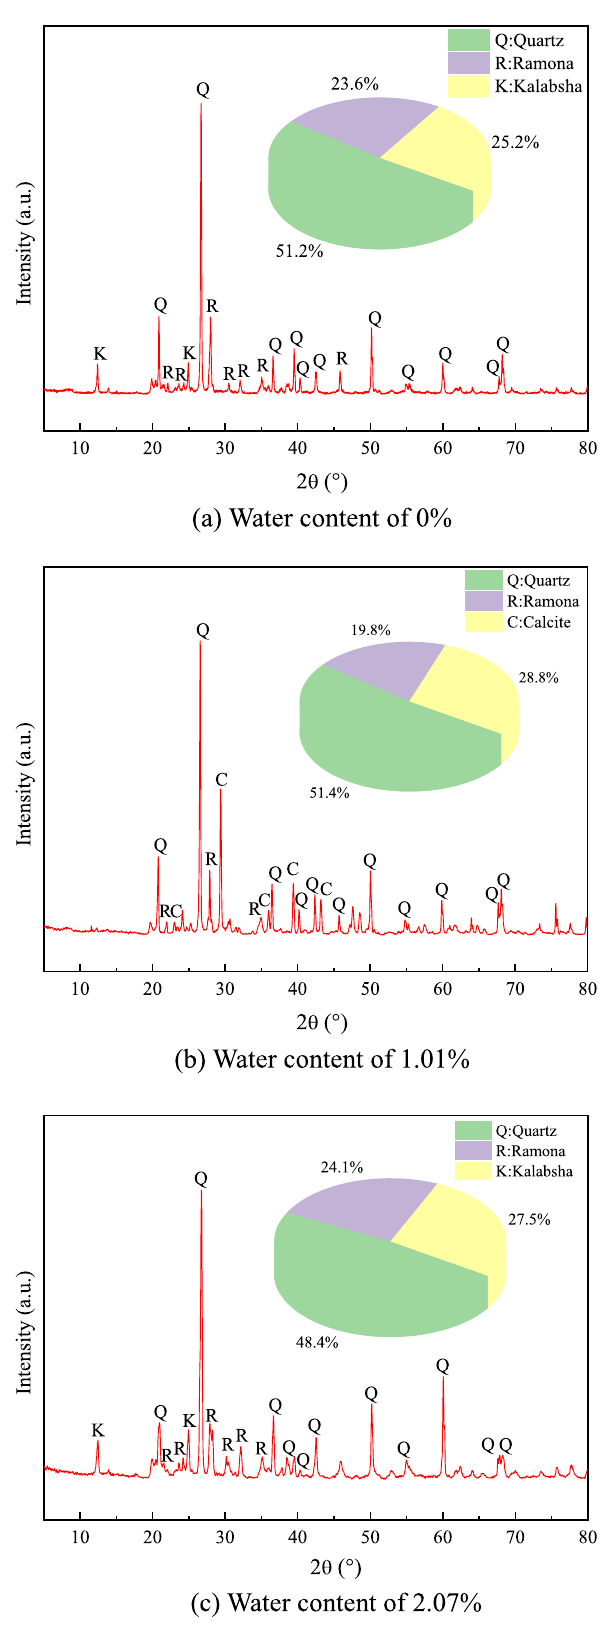
Fig. 7 XRD patterns of sandstone